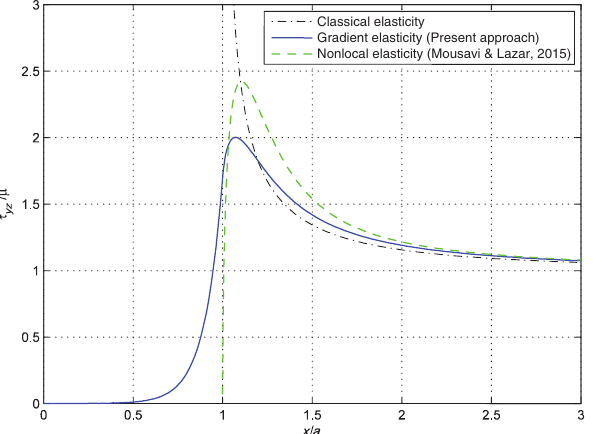
Figure 3: Normalized stress component τ son with classical and nonlocal elasticity.